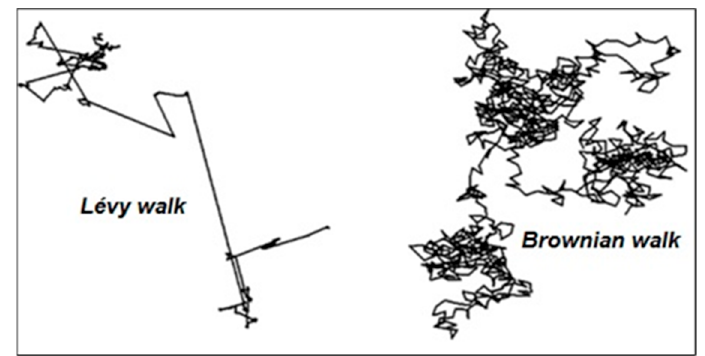
Figure 2. Trajectories of Levy flight and Brownian motions.